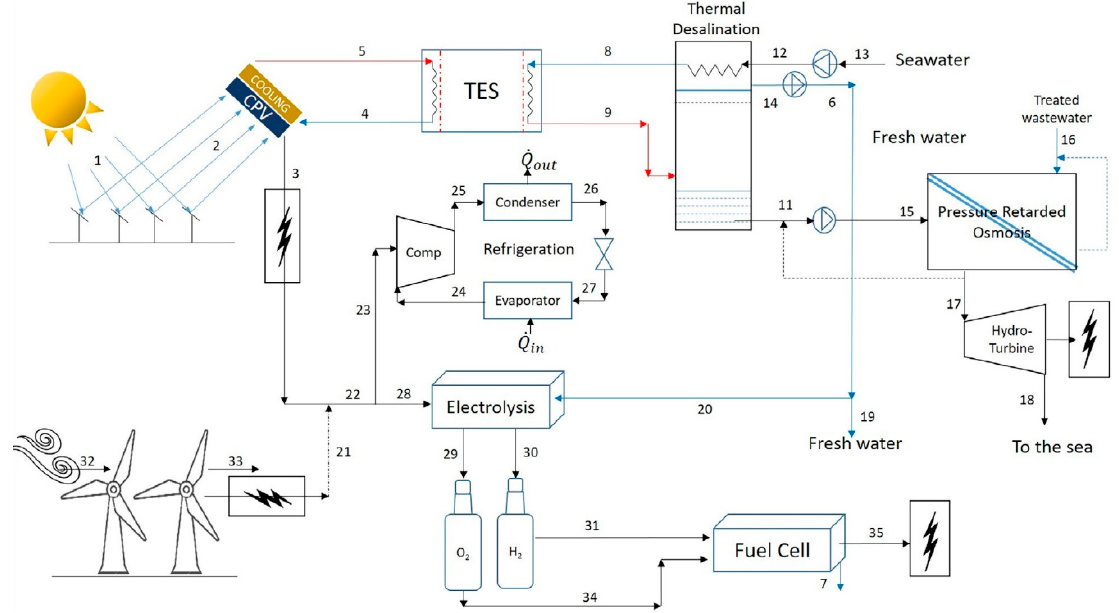
Figure 8. Schematic diagram of the multigeneration system proposed by Sezer and Koç [76]. CPV, concentrated photovoltaic; TES, thermal energy